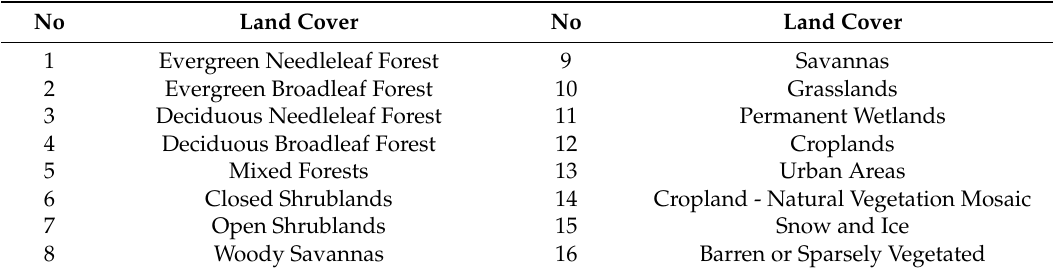
Table A1. Land Cover types corresponding to the integer in Tables 2–9. Defined according to the International Geosphere-Biosphere Programme